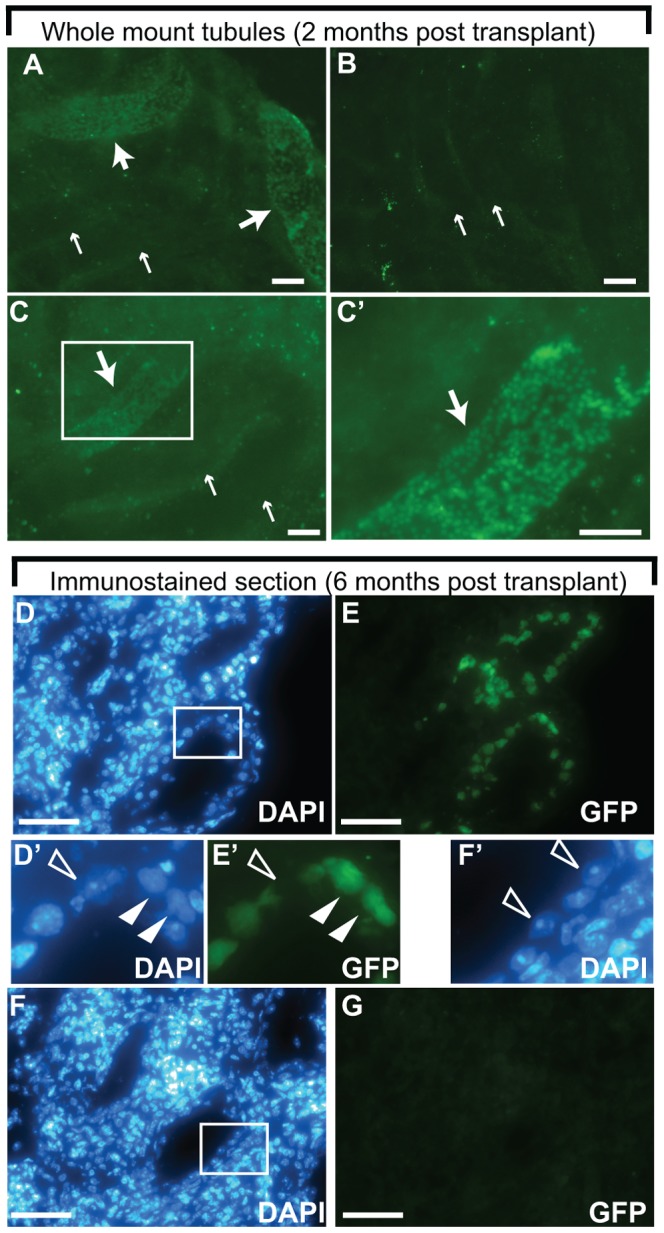
Colonization by gene-corrected GS cells following testicular transplantation.(A) Whole mounted squash preparation of seminiferous tubules depicting a seminiferous tubule (arrows) extensively colonized by gene-corrected GT59 SSCs two months following transplantation into a KitW-v/KitW sterile pup testis. (B) Non-transplanted control. (C) Whole mounted squash preparation of seminiferous tubules depicting a colony of GT65 SSCs two months following transplantation into a busulfan treated adult testis. Visualization of GT65 cells was facilitated by modification with Histone-GFP lentivirus prior to transplant. (A–C) Large arrowheads indicate GFP+ colonies and small arrows indicate autofluorescence in nearby tubules. Bar  = 100 microns. (C′) Higher magnification image of the boxed area in (C). Bar  = 50 microns. (D–G) Immunostaining with anti-GFP antibody (E, G, E′) or DAPI staining (D, F, D′, F′) of a cryosection of a GT59 colony 6 months following transplantation into KitW-v/KitW pup testis (D, E, D′, E′) or non-transplanted control testes (F, G, F′). Boxed area in D corresponds to the higher magnification view in D′ and E′. Triangles indicate donor-derived GFP+ cells. Boxed area in F corresponds to the higher magnification view in F′ and depicts the “Sertoli Cell Only” phenotype of non-transplanted KitW-v/KitW testes. The Sertoli cells are indicated by open triangles. Bar  = 25 microns.